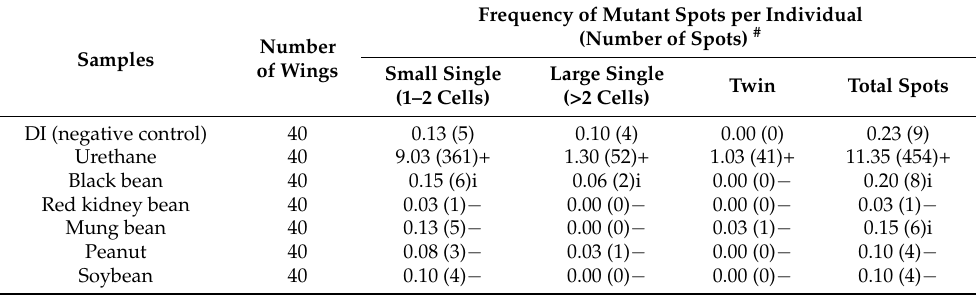
Table 1. Frequency of mutant spots observed in trans-heterozygous, high bioactivation (HB) flies treated with DI, urethane or bean milks in the co-administration study.